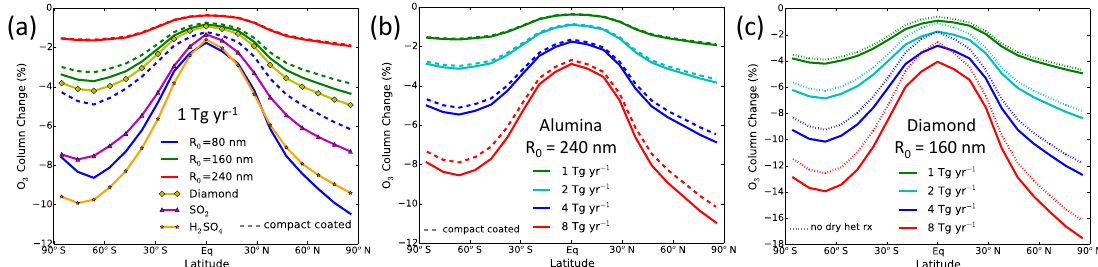
Figure 12. Annual average column ozone change in percent as a function of latitude for (a) cases with 1Tgyr − 1 injections of alumina monomers of 80nm, 160nm, and 240nm, and diamond monomers of 160nm and SO 2 and H 2 SO 4 , (b) cases with injection of 240nm alumina monomers at rates of 1, 2, 4, and 8Tgyr − 1 , and (c) cases with injection of 160nm diamond monomers at rates of 1, 2, 4, and 8Tgyr − 1 . Cases in which coated particles are assumed to become more compact in shape are shown with dashed lines in panels (a) and (b) . For diamond, cases without Reaction (R1) occurring on dry diamond particle surfaces are shown with dotted lines in panel (c) .